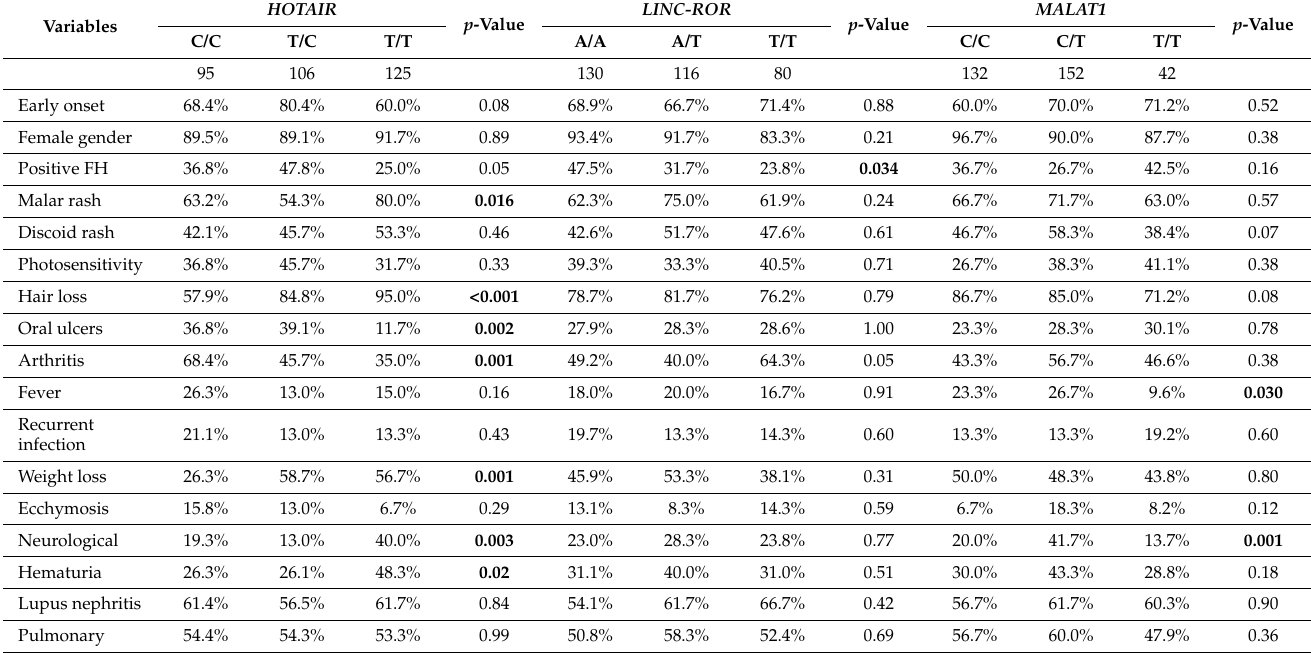
Table 3. Association of lncRNA polymorphisms with clinical parameters.